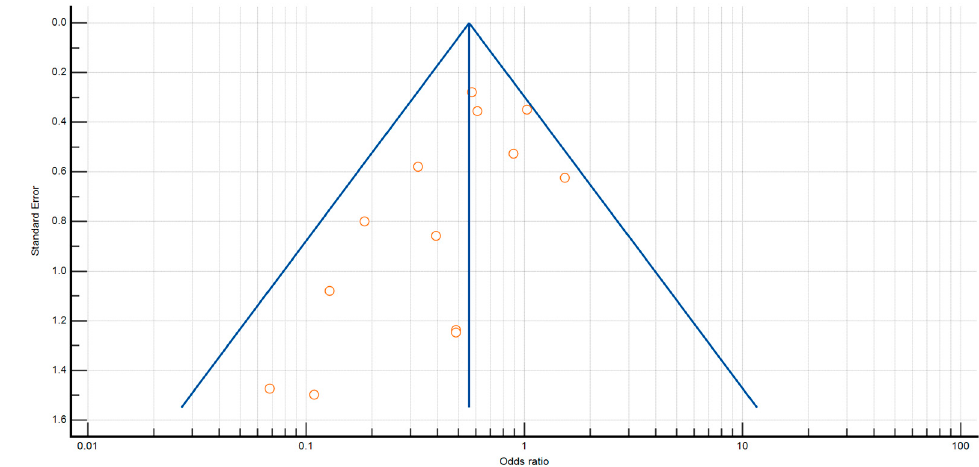
Figure 2. Funnel plot for anastomotic leaks.